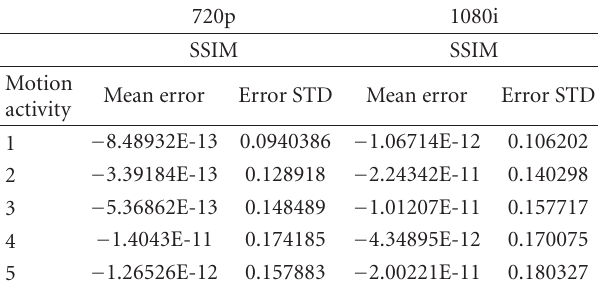
Table 4: Mean errors and standard deviations of model for Qm B1